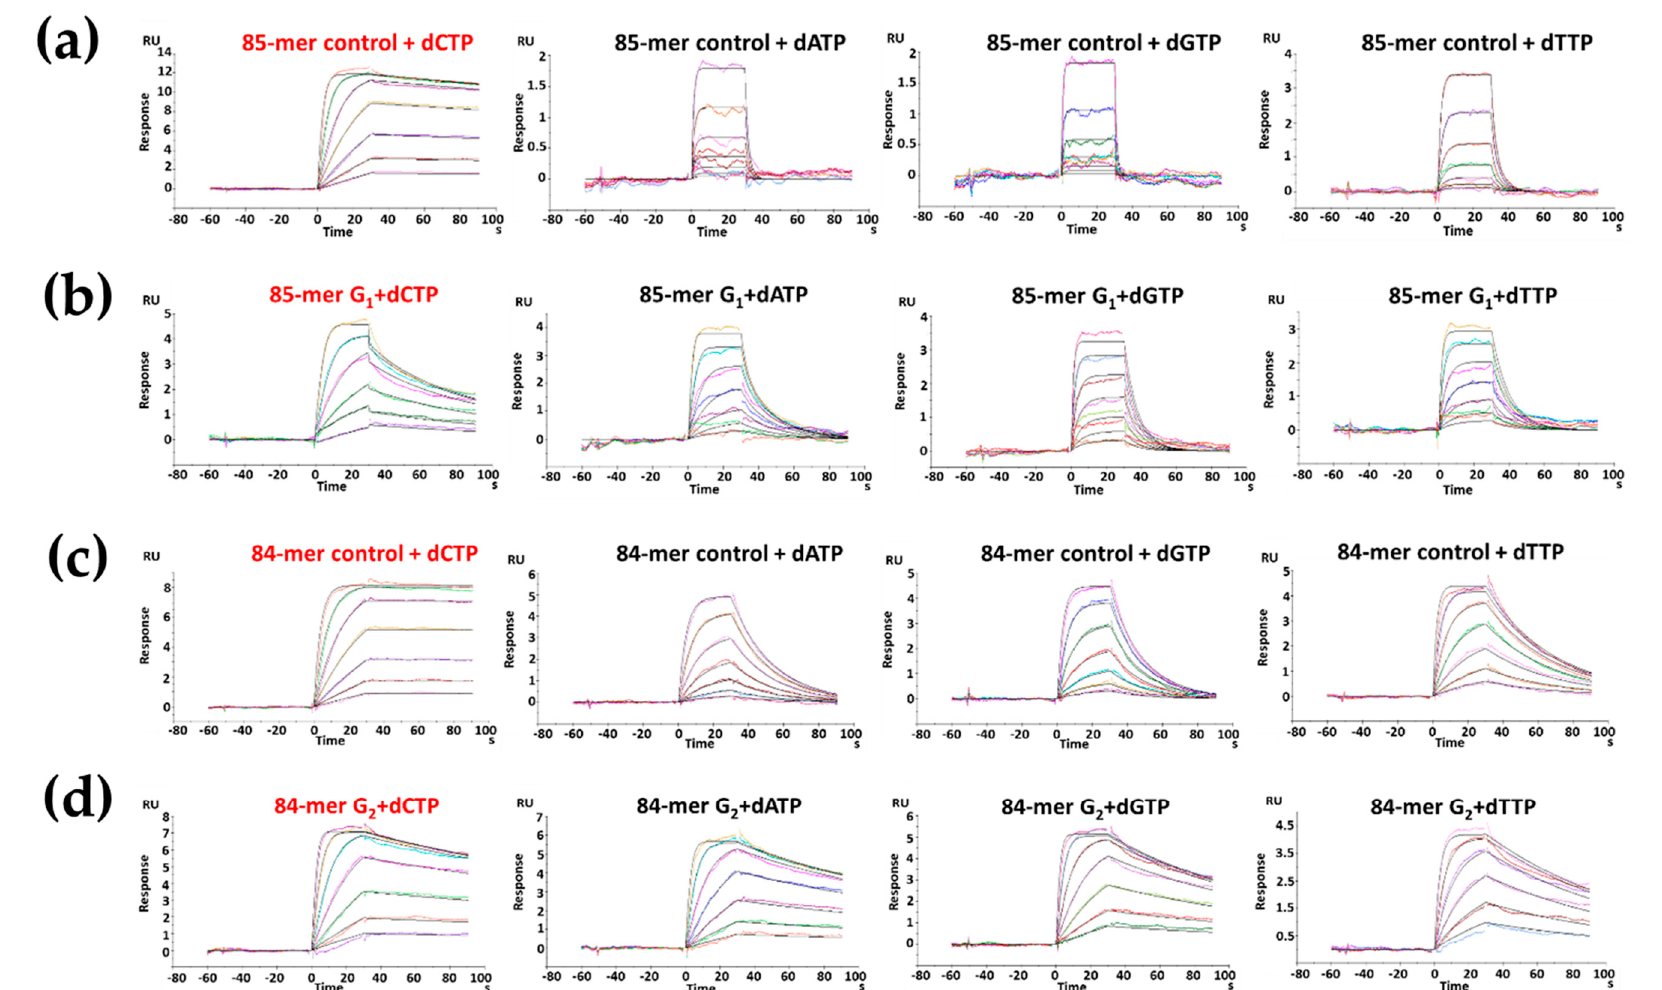
Figure 4. Sensorgrams of the ternary Kf-exo − complexed with ( a ) 85-mer control, ( b ) 85-mer TG 1 [FABP]G 2 T, ( c ) 84-mer control and ( d ) 84-mer TG 1 G 2 [FABP]T sequences in the presence of dNTPs (1:1 binding fitted curves are overlaid as black lines).